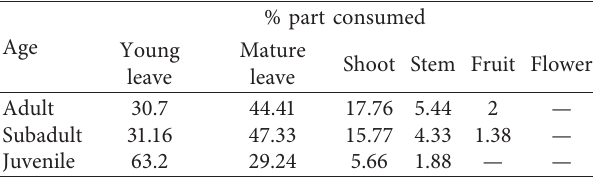
Figure 2: Percentage of plant part consumption by klipspringers during dry and wet seasons. Table 2: Percentage of plant parts consumed by klipspringers.